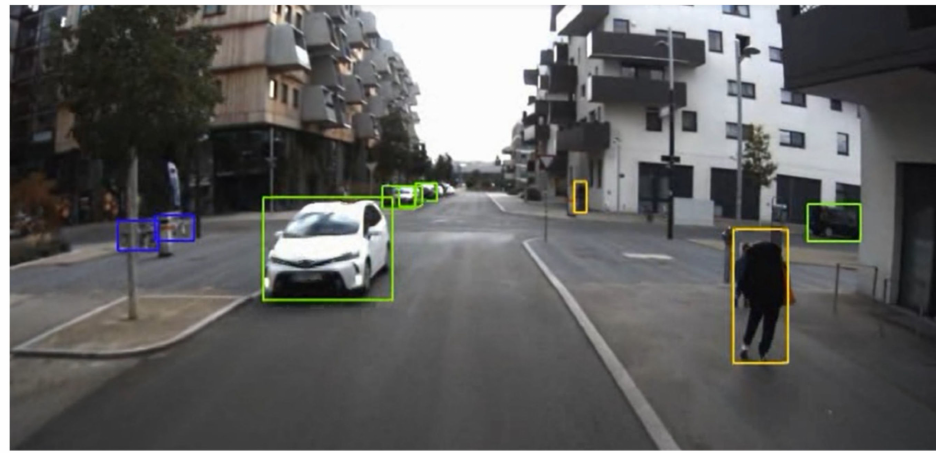
Figure 2. Overlay of the bounding boxes onto the image of the road. Pedestrians indicated by yellow, cars by green and bicycles by blue bounding